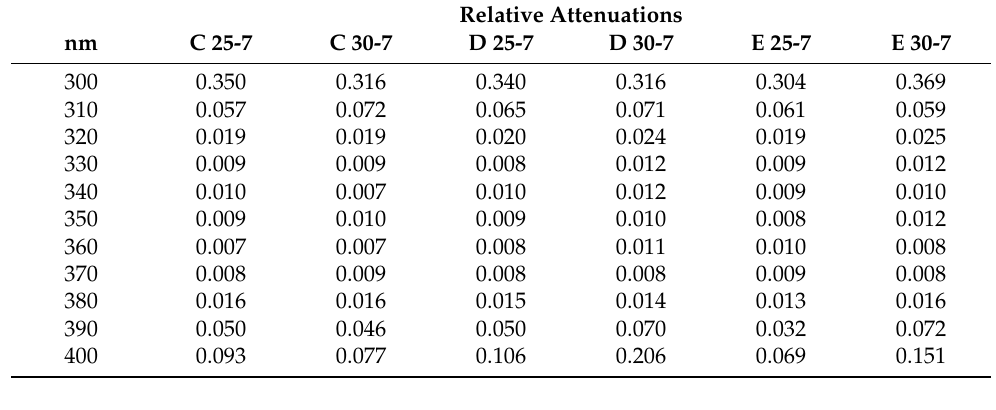
Table 9. Values of the spectral relative attenuations for the UV band for the three interior locations for the two skylight states (25-7 without water and 30-7 with water) at 15 solar hours.